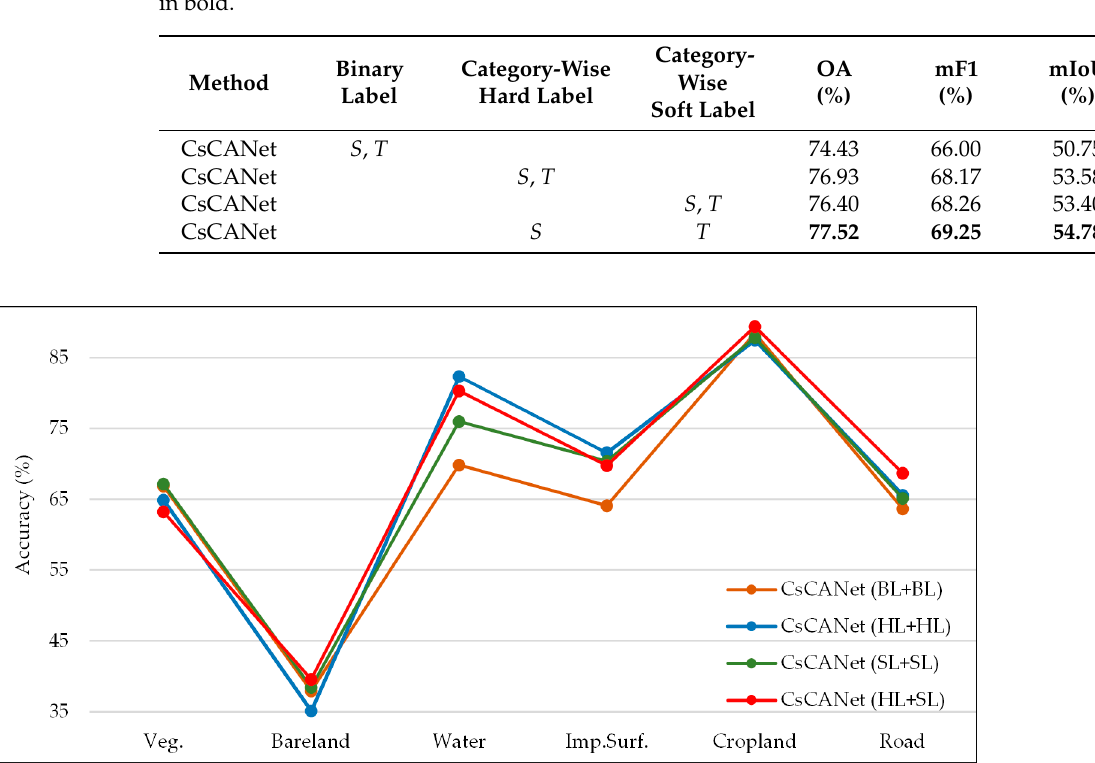
17 of 21 Figure 8. Representative examples of land cover mapping on the task Shanghai → Zhejiang: ( a ) baseline, ( b ) single-level CsCANet, ( c ) multi-level CsCANet. RGB images and the corresponding ground truth are presented in unison. We circle the negative results in white ellipses. 5.1.2. Design of Domain Labels Extraction Module A conventional discriminator always employs a global adversarial loss to implement feature alignment via a binary domain label. Paying attention to the underlying category- space in the target domain, we introduced a category-wise discriminator with two